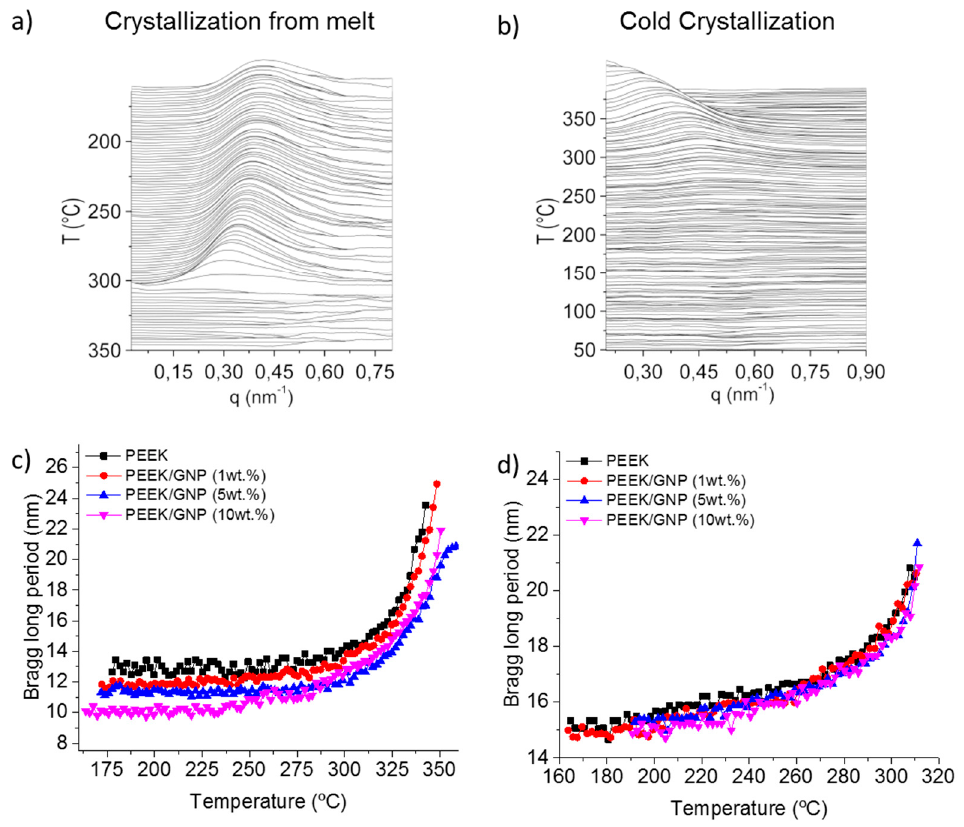
Figure 9. Small angle synchrotron X-ray radiation (SAXS) synchrotron profiles corresponding for pure PEEK samples, crystallization from melt ( a ), crystallization from glass ( b ). Temperature dependence, on Bragg long period for samples crystallized during cooling from melt ( c ), and during heating from glass phase ( d ).